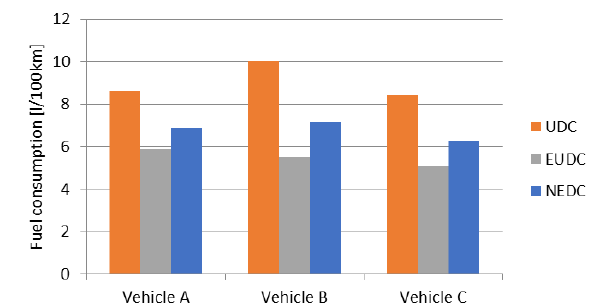
Fig. 2. Fuel consumption in NEDC test and its particular stages